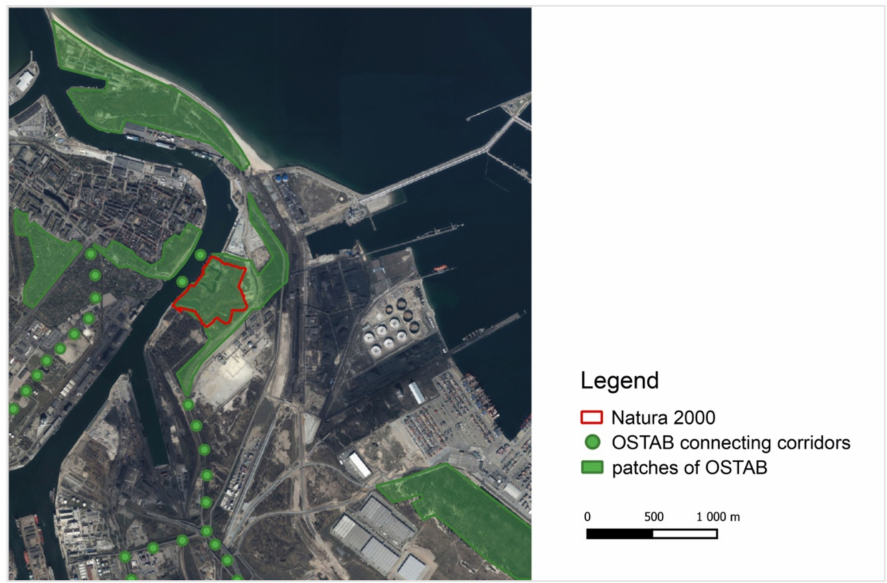
Figure 20. The Natura 2000 Wisłouj´scie Fortress with identified OSTAB elements including the OSTAB core nature matrix and OSTAB connecting corridors. Source: authors’ elaboration based on